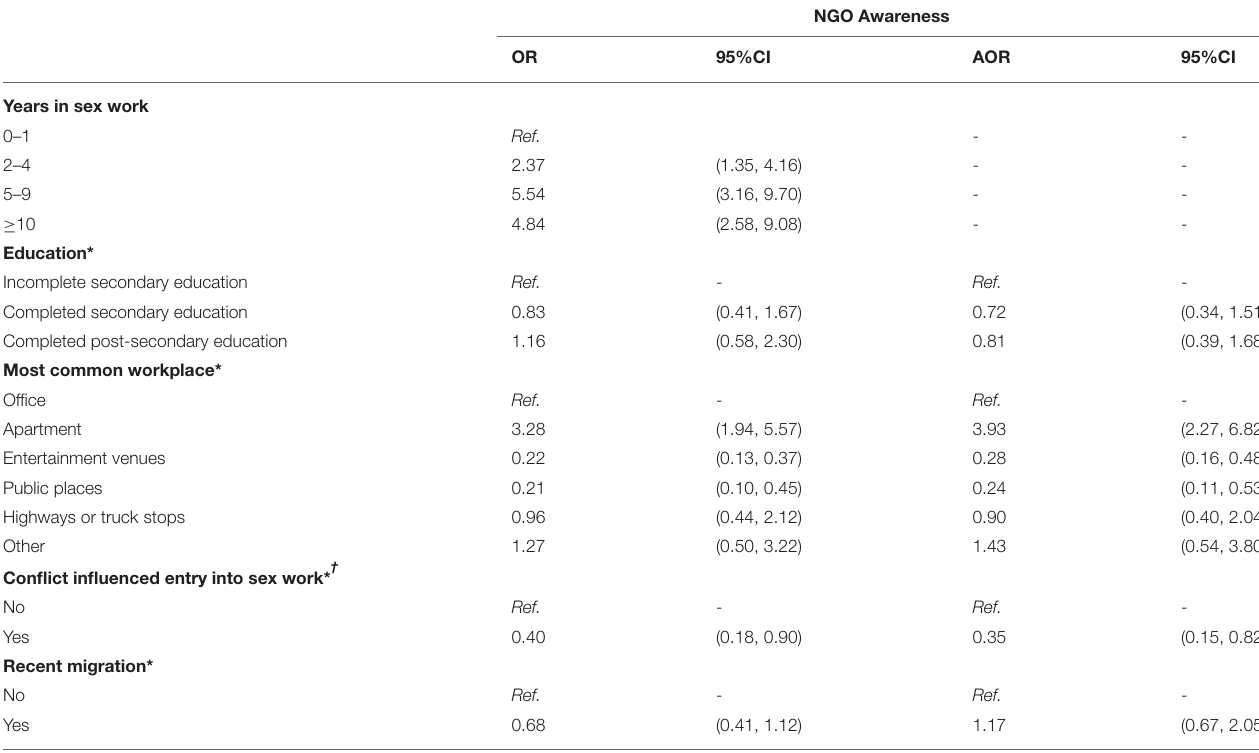
TABLE 3 | Crude (OR) and adjusted odds ratios (AOR) with 95% confidence intervals (95%CI) from logistic regression models examining correlates of NGO awareness among female sex worker